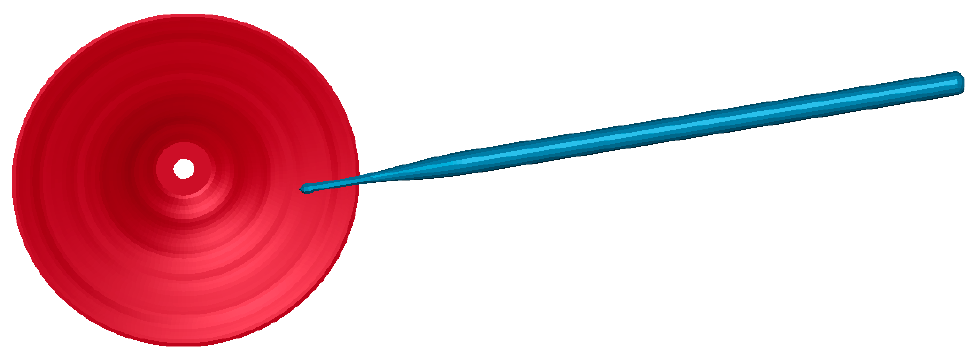
Figure 1. The CAD models of the splash cymbal and the drumstick.